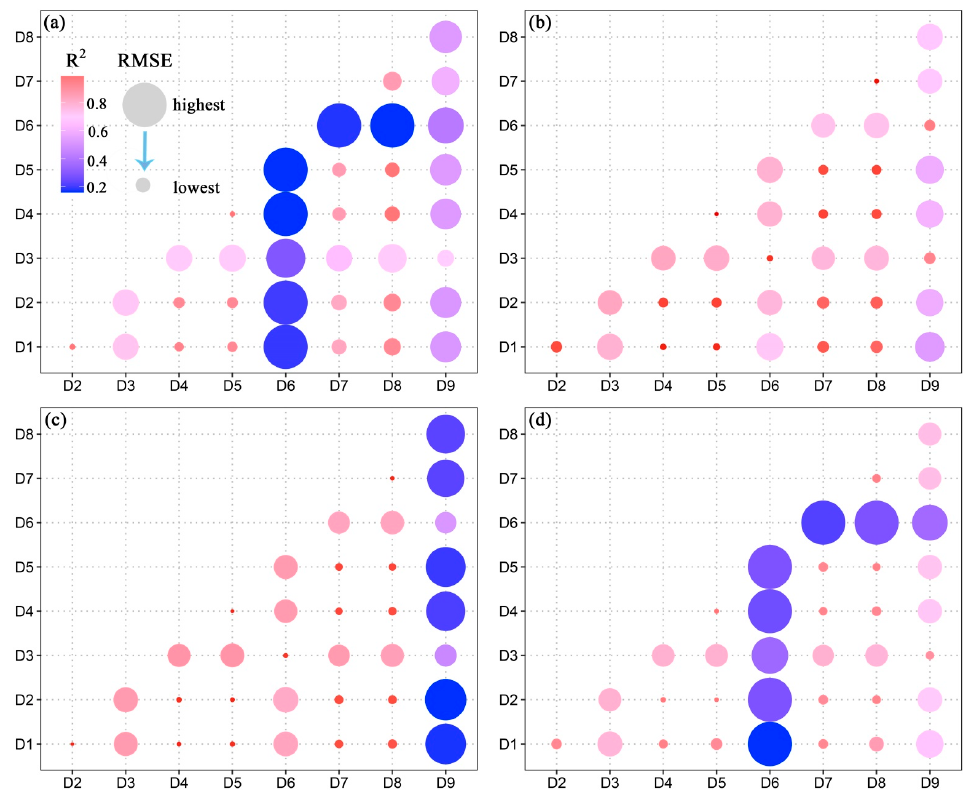
Figure 12. Linear regression results between the up-scaled EOSs at ( a ) 2 km, ( b ) 4 km, ( c ) 6 km, and ( d ) 8 km. D1 is the SOS up-scaled from the SOS derived from the 250 m AG-filtered NDVI. D2 is the SOS up-scaled from the SOS derived from the 250 m DL-filtered NDVI. D3 is the SOS up-scaled from the SOS derived from the 250 m SG-filtered NDVI. D4 is the SOS up-scaled from the SOS derived from the 500 m AG-filtered NDVI. D5 is the SOS up-scaled from the SOS derived from the 500 m DL-filtered NDVI. D6 is the SOS up-scaled from the SOS derived from the 500 m SG-filtered NDVI. D7 is the SOS up-scaled from the SOS derived from the 1000 m AG-filtered NDVI. D8 is the SOS up-scaled from the SOS derived from the 1000 m DL-filtered NDVI. D9 is the SOS up-scaled from the SOS derived from the 1000 m SG-filtered NDVI. (AG is the asymmetric Gaussian filter, DL is the double logistic filter, and SG is the Savitzky-Golay filter). All linear regression equations pass the F-test at a significance level of